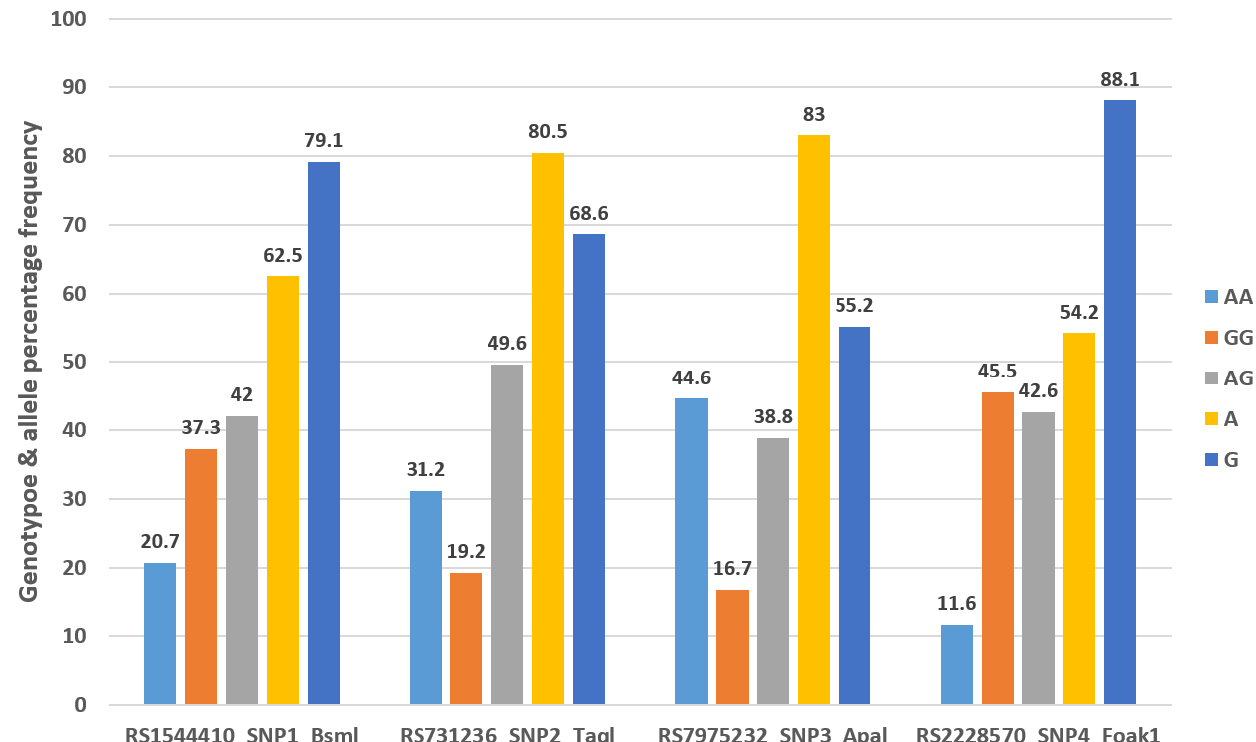
Figure 1. Genotype and allele percentage frequency distribution of four VDR gene polymorphisms in the Emirati population.